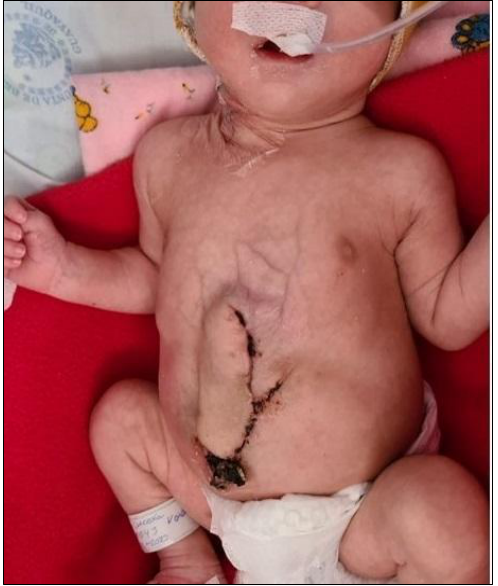
Figure 3: Final outcome after excision of the HT and omphalocele